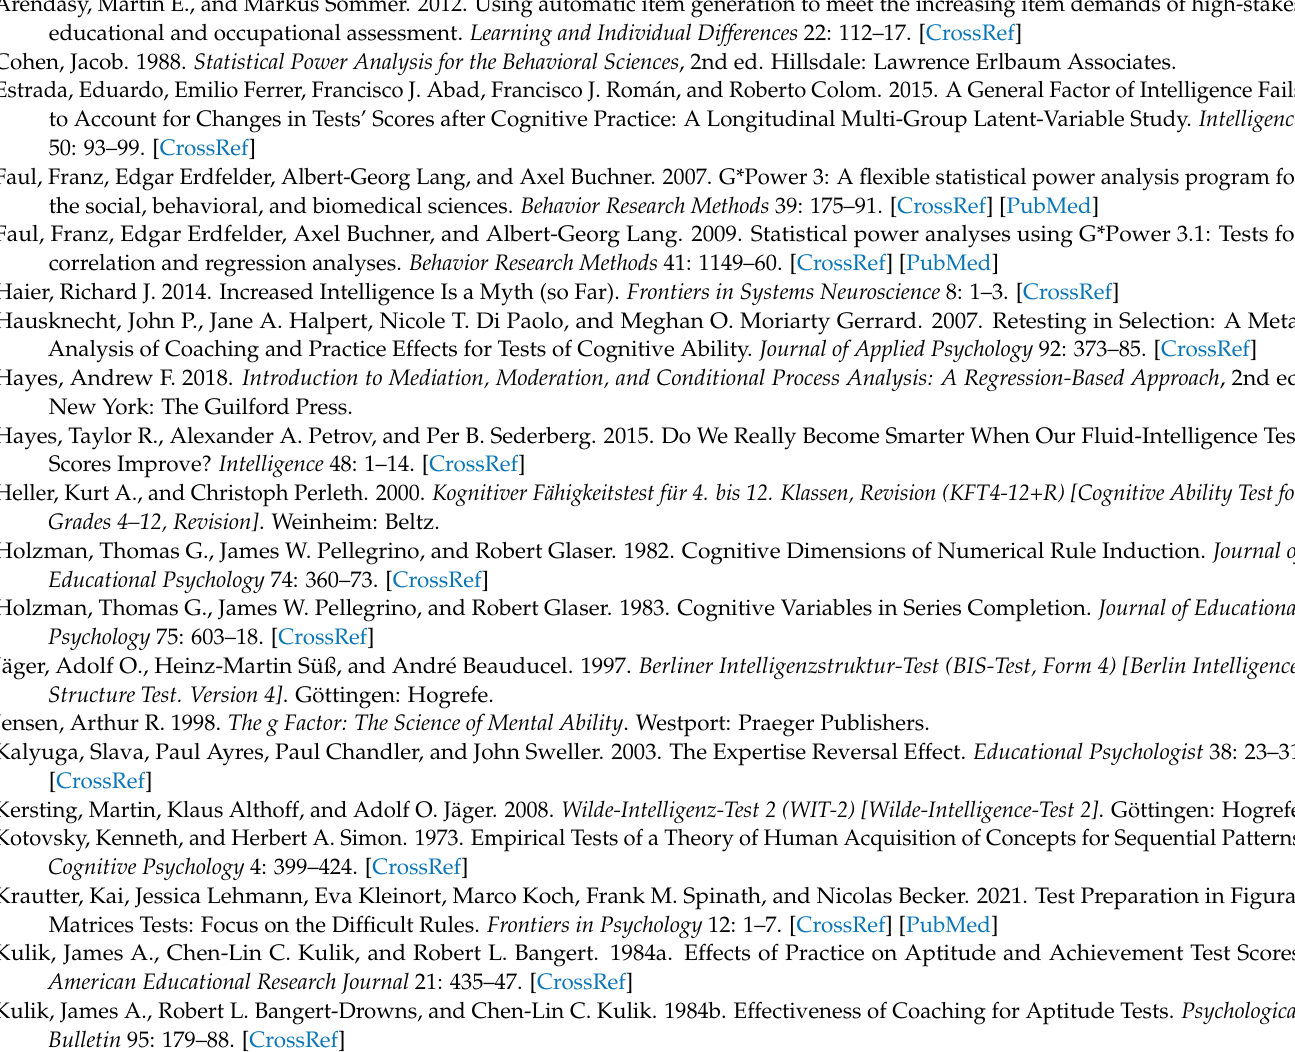
figural analogies to assess figural reasoning as well as the sum score indicating an approximation of general intelligence) available for N = 99 participants, there were no statistically significantly mean differences between the students of both groups: t (df adjusted = 93.39) = .42; p =